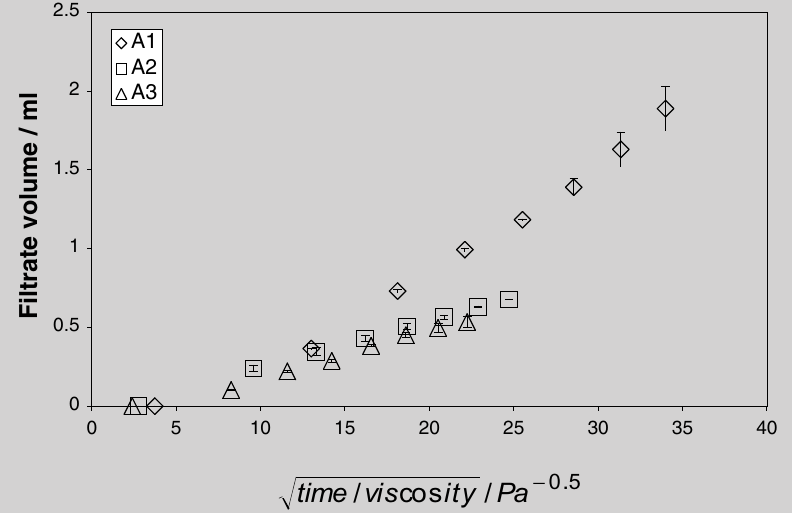
Figure 5: Filtrate volume versus (t/ h ) 1/2 for coating colours A1, A2 and